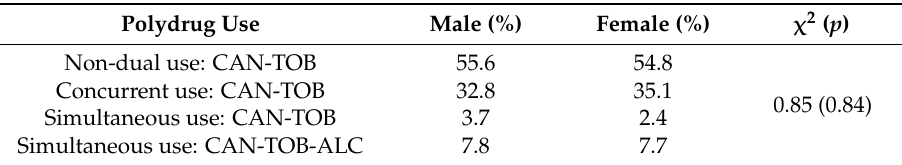
Table 1. Patterns of polydrug use by gender.